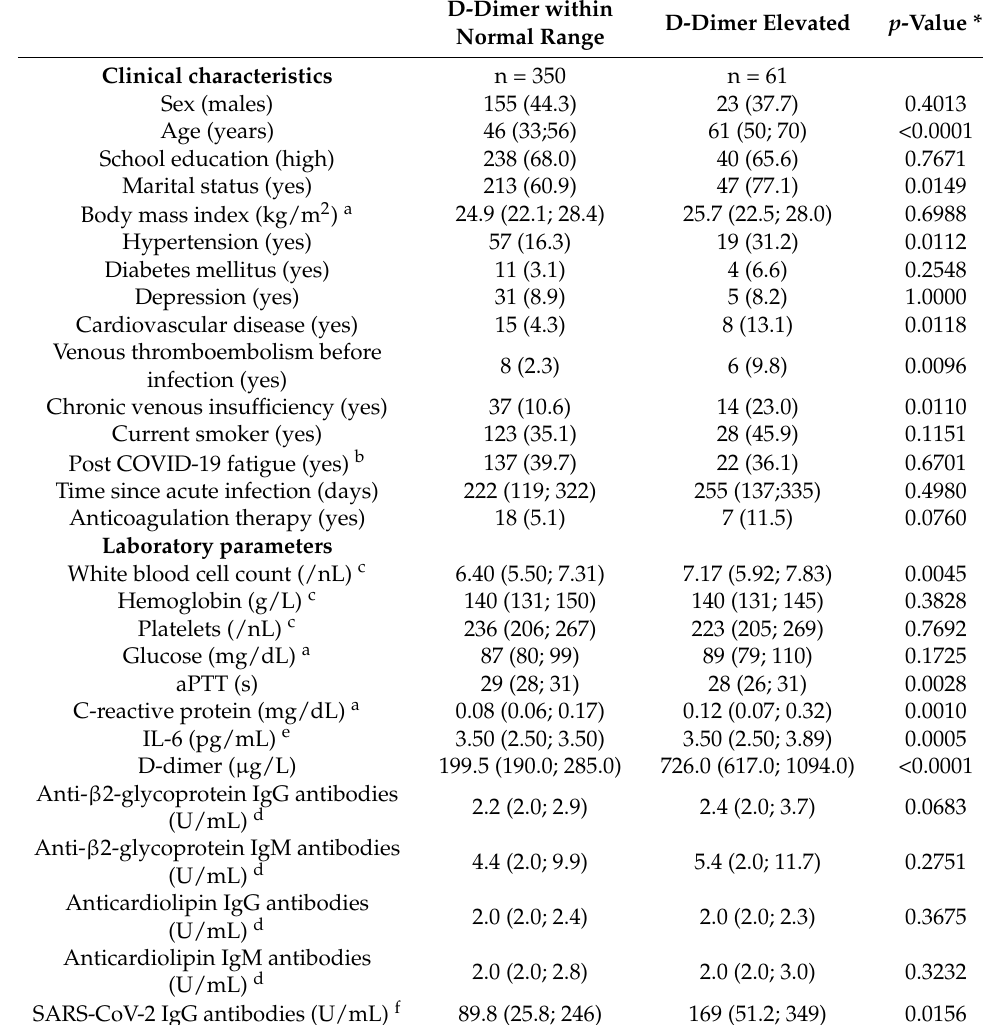
Table 1. Characteristics of post-COVID-19 patients treated as outpatients (given as frequencies and percentages, or median and interquartile range), by elevated or normal-range plasma D-dimer concentrations.